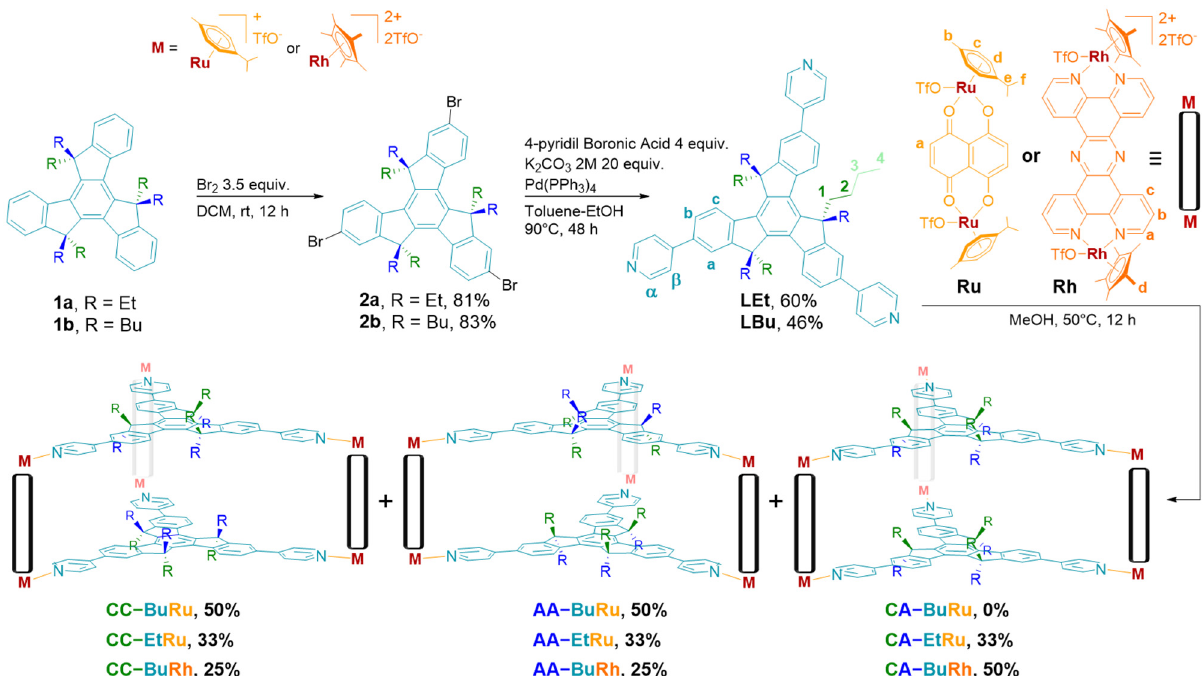
Figure 2. X-Ray crystal structures of LEt (left) and LBu (right): ( a , c ) top views (clockwise face in green); and ( b , d ) lateral views showing both rotating faces (clockwise in green, anticlockwise in blue).